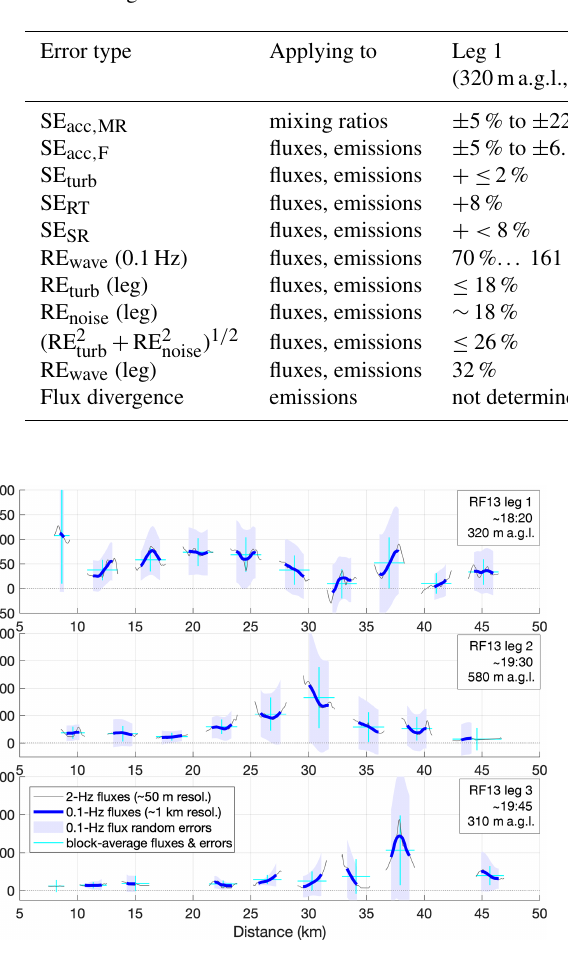
Table 1. Estimates for systematic errors (SEs) and random errors (REs) for the case study of flight RF13. Descriptions for each error type are given in the text (Sect. 3.8). For SEs, signs indicate error direction relative to the absolute values of measured fluxes; “ ± ” means the direction could be either side. Ranges of errors, indicated by “... ”, correspond to leg-wide interquartile ranges; errors without ranges apply to each flux in the leg.